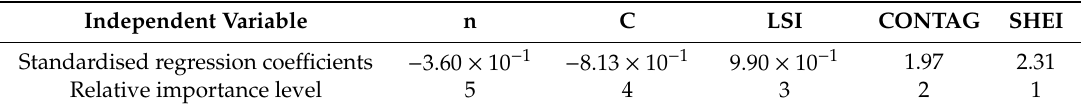
Table 8. Standardised regression coe ffi cients result.